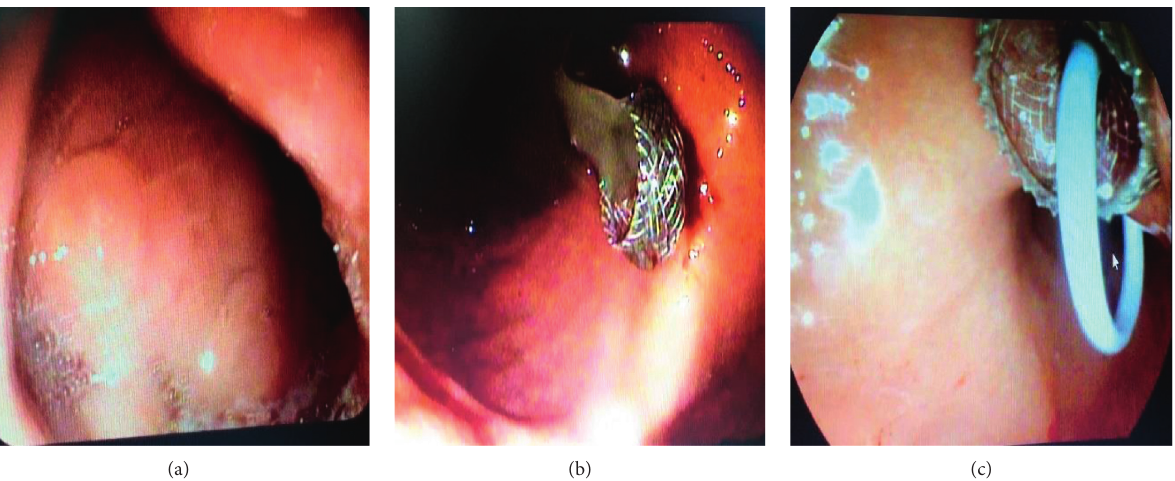
Figure 7: Endoscopic view during pseudocyst drainage showing (a) the pseudocyst bulging the gastric mucosa, (b) drainage from the pseudocyst, and (c) AXIOS and double-pigtail